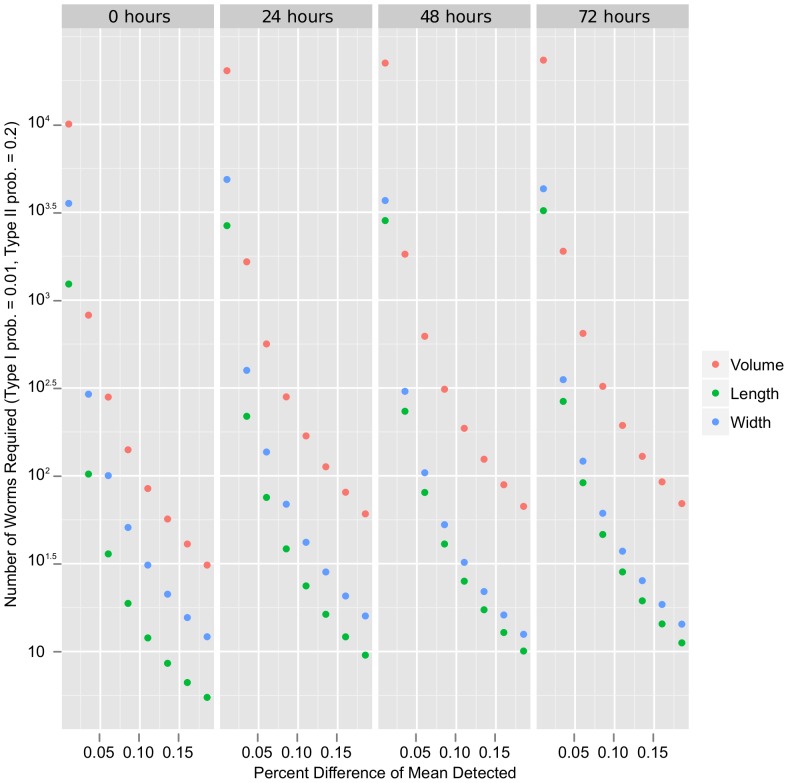
WormSizer can detect differences in size with relatively few samples.Results of a power analysis (t-test, two-sample, two-sided alternative, Type I error probability at 0.01, Type II error probability at 0.2) are plotted for each time point. Less than a hundred individuals are required to detect a 15% difference in volume between populations, and less than three hundred are required for a 10% difference.